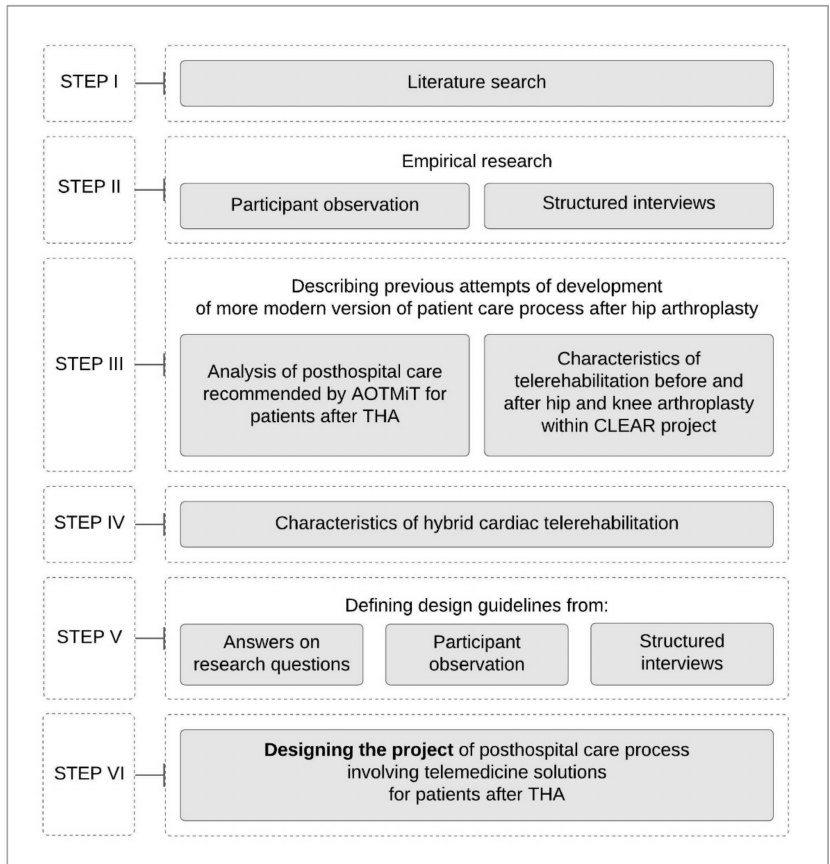
Figure 2. Research process